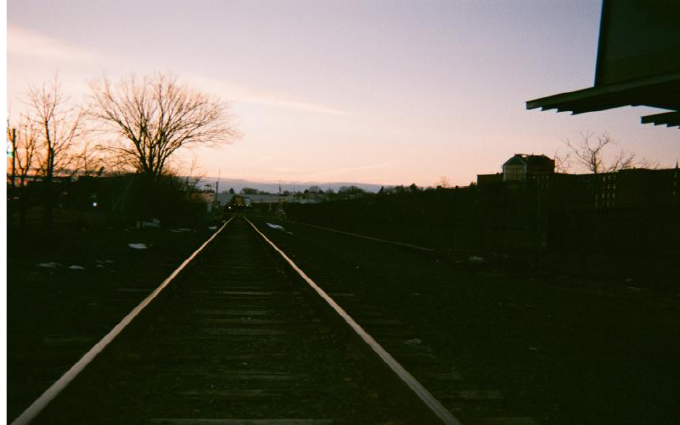
Figure 2. PTSD associated with violent demolition of tent